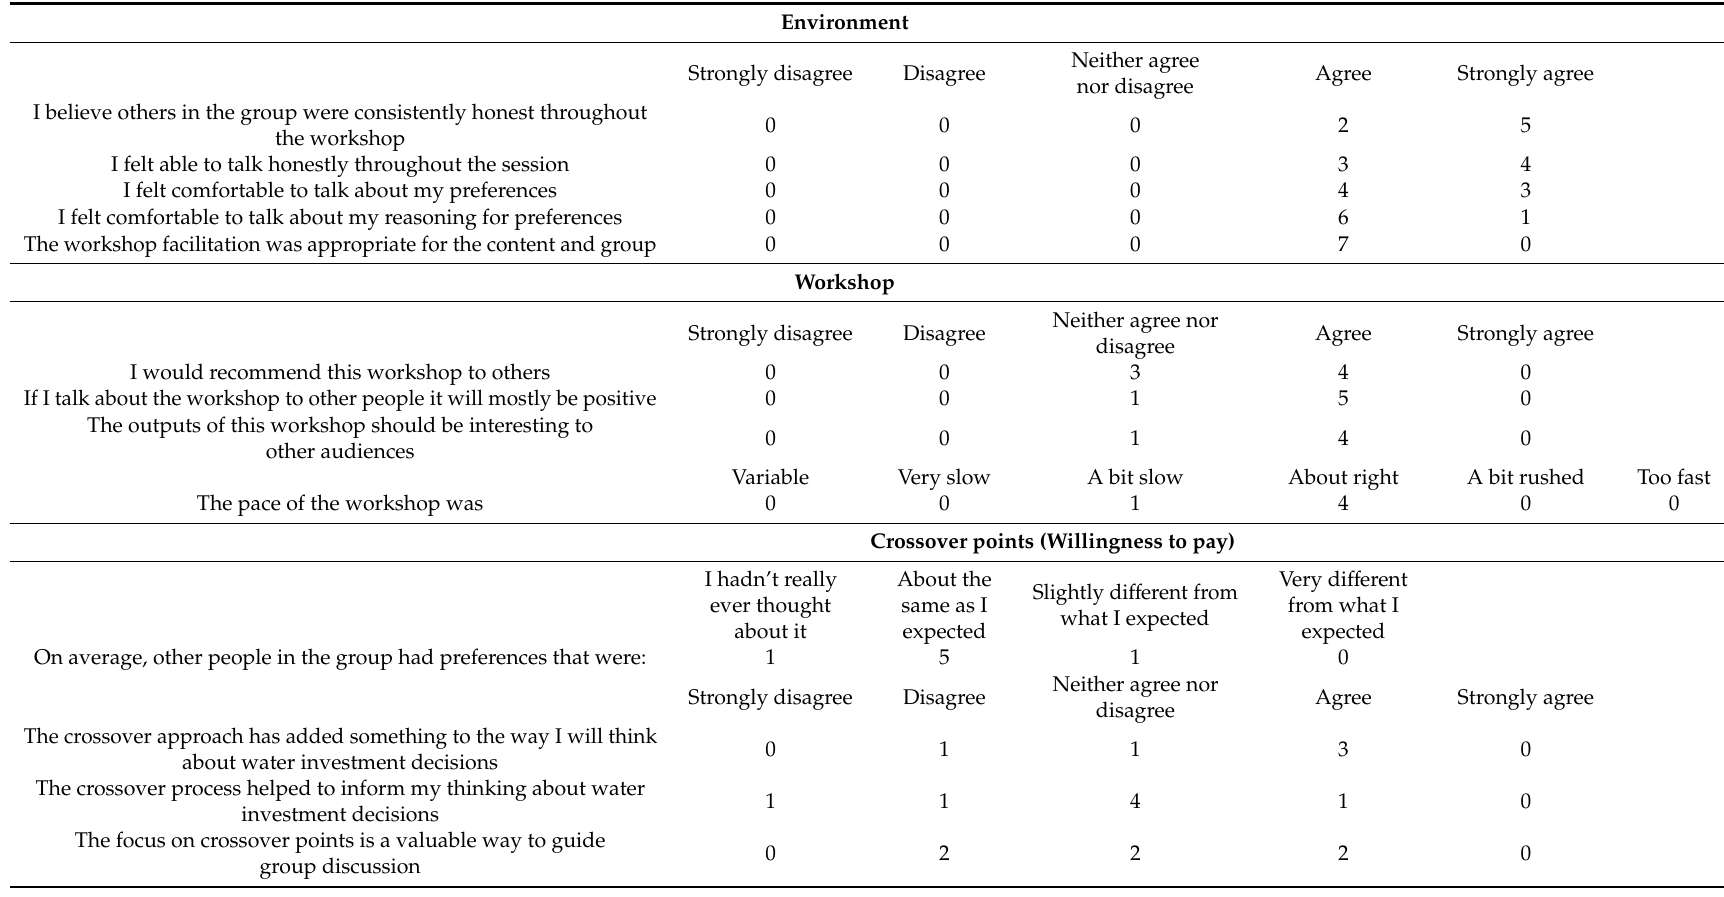
Table 2. Results from the evaluation immediately after the